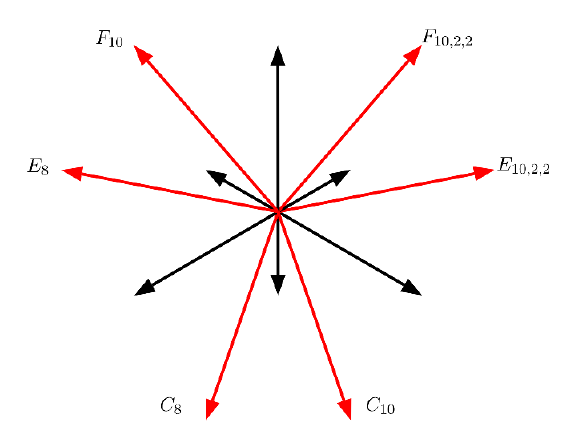
Figure 3 . The identi(cid:12)cation of the long weights of the 15 of SL(3 ; R ) with the IIB potentials. The table should be compared with table